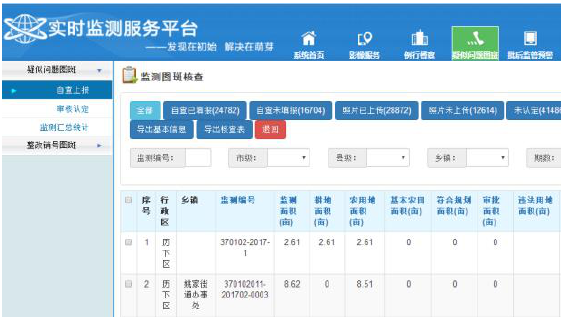
Figure 7. Monitoring patches supervision function interface